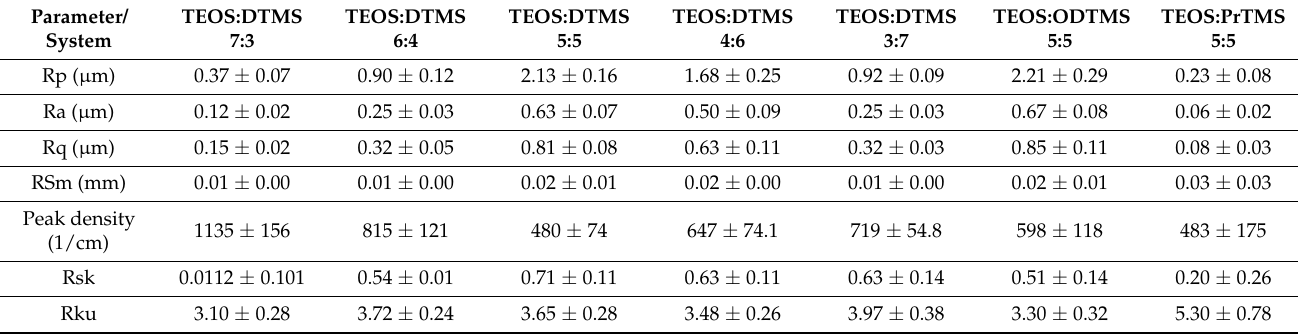
Table 5. Confocal microscopy morphological characteristics, where Rp ( µ m) is the maximum peak height of the roughness profile, Rq ( µ m) is the root-mean-square (RMS) deviation of the roughness profile, Ra ( µ m) is the arithmetic mean deviation of the roughness profile, RSm (mm) is the mean width of the roughness profile elements, peak density (1/cm) is the peak count of the roughness profile, Rsk is the skewness of the roughness profile, and Rku is the kurtosis of the roughness profile. Parameter/